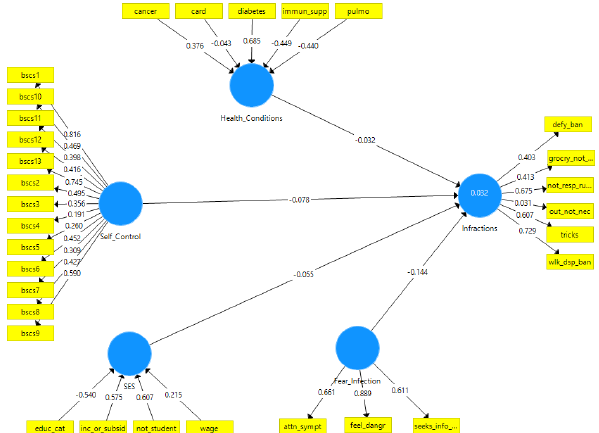
Figure 1. Model 1 : Direct effects only. Please refer to Appendix A Table A1 for the exact wording of indicators. The outcome (infractions) is predicted by four latent variables indicated by circles (self-control, health conditions, SES, and fear of infection). Rectangles are the observed variables. Arrows terminating in infractions are regression coefficients. Arrows originating from a latent variable (reflective) and terminating in a rectangle represent loading. Arrows originating from a rectangle and ending in a latent variable (formative) represent weights.